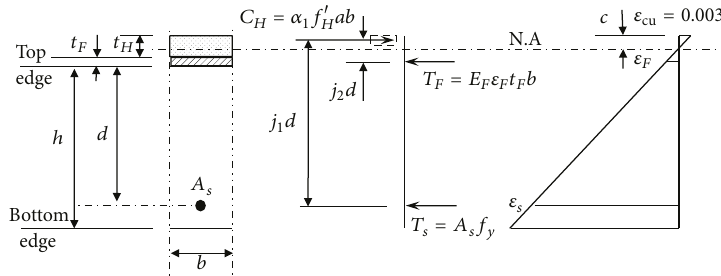
Figure 2: Enhancing mechanism of the proposed retrofit system for the positive moment sections of RC slabs.